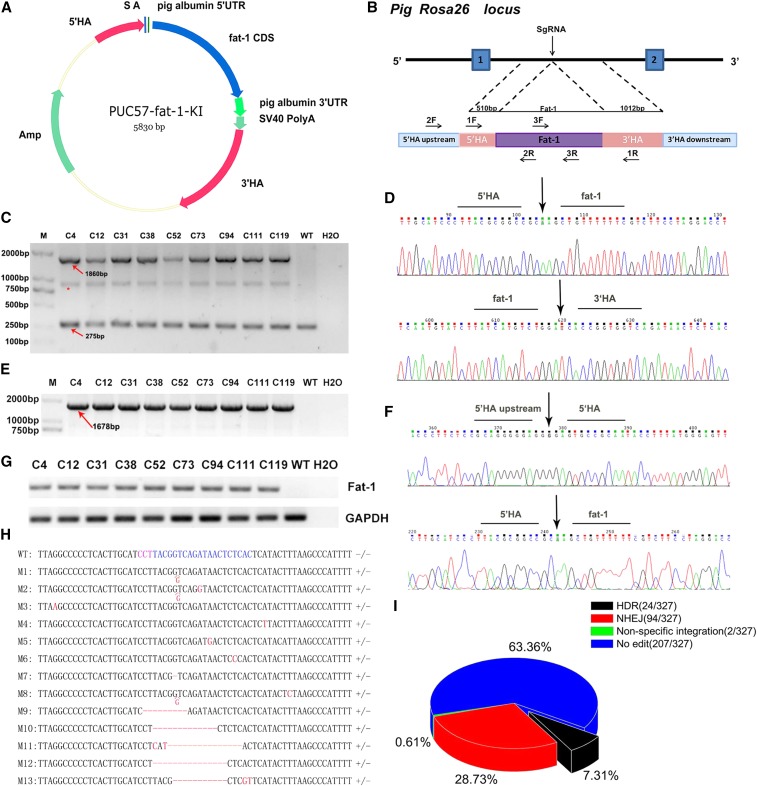
Site-specific fat-1 knock-in at the pRosa26 locus. (A) Schematic of the donor plasmid for the fat-1 insertion. 5′HA, 5′ homologous arm (0.5 kb); 3′HA, homologous arm (1.0 kb); (B) Strategy of Cas9-mediated knock-in of fat-1 into the pRosa26 locus; (C) PCR analysis of the PFF clones using primer pair 1F/1R. The 1F primer was designed in 5′ HA and the 1R primer designed in 3′ HA. M: D2000. WT: negative control. H2O: blank control. *: A hybrid band formed by knock-in band and wild-type band in the process of genomic PCR of heterozygous animals; (D) Sanger sequencing results of the PCR products in (C) ; (E) PCR analysis of the PFF clones using primer pair 2F/2R. The 2F primer was designed upstream of 5′ HA and the 2R primer was designed in the fat-1 CDS; (F) Sanger sequencing results of the PCR products in (E) ; The primer pair 1F/1R was used to identify the insertion of the fat-1 gene whereas the primer pair 2F/2R was used to identify the site-specific integration of fat-1; (G) RT-PCR was performed to confirm the transcription of the fat-1 gene in genetically positive clones using the 3F/3R primer (268bp) ; (H) The wild-type sequence is placed on the first line and the mutation sequence of single-cell clones were placed below. The PAM was marked in purple and the target site was marked in blue. −/− means wild-type allele and +/− means NHEJ occurred in one allele; (I) The HDR, NHEJ and non-specific integration ratio of 327 individual cell cones.